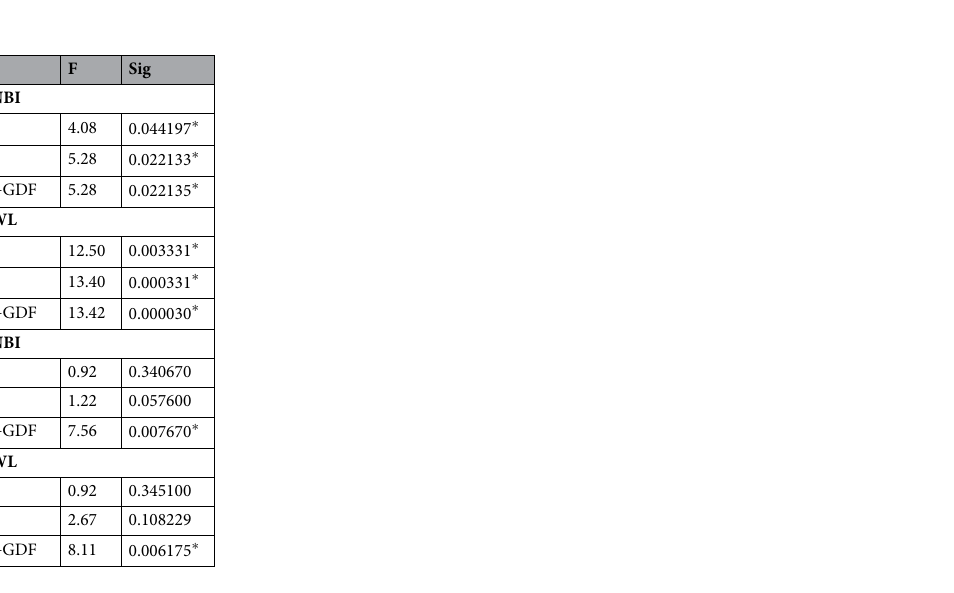
Table 2. Statistical significance test on selected features using fuzzy entropy. *Significant difference in Independent Sample t-test w.r.t. classes